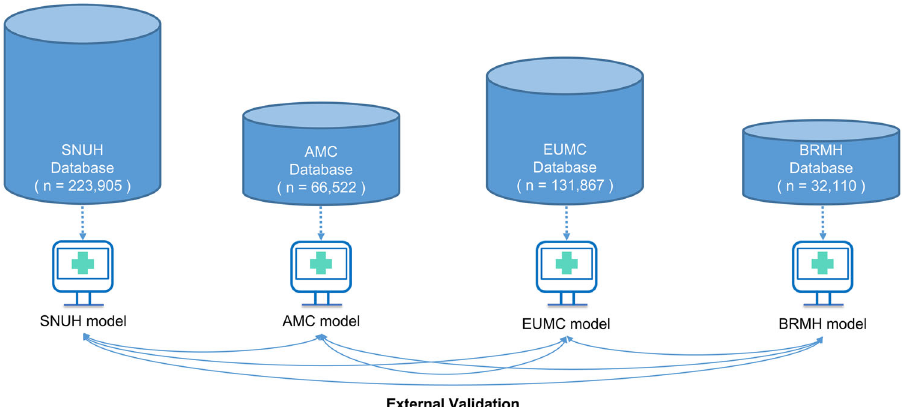
Fig. 3 Schematic diagram of external validation of each hospital model. SNUH Seoul National University Hospital, AMC Asan Medical Center, EUMC Ewha Womans University Medical Center, BRMH Boramae